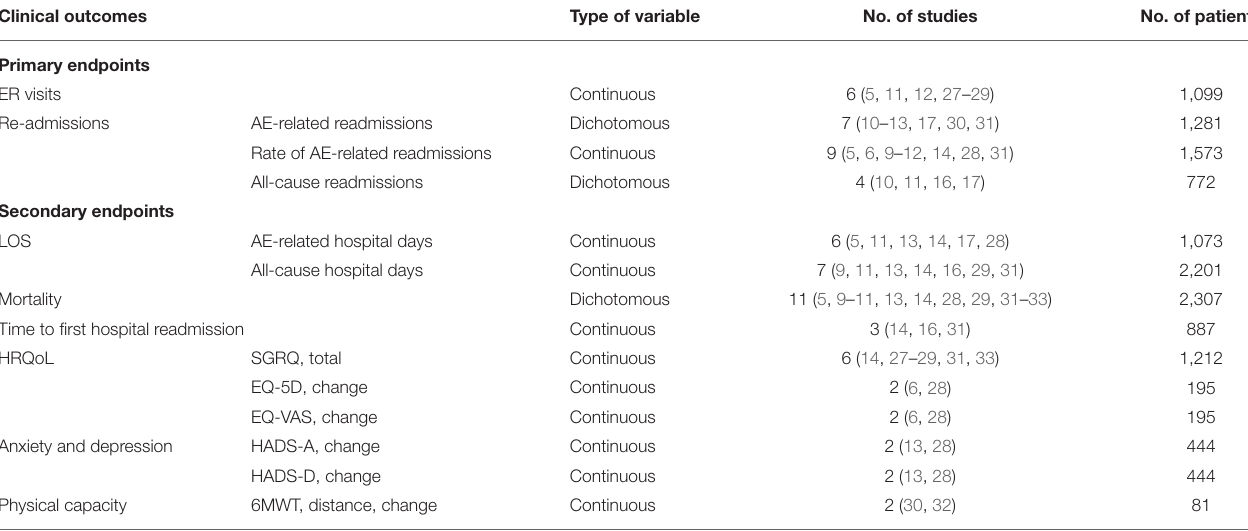
TABLE 1 | TM studies and pooled clinical outcomes. Clinical